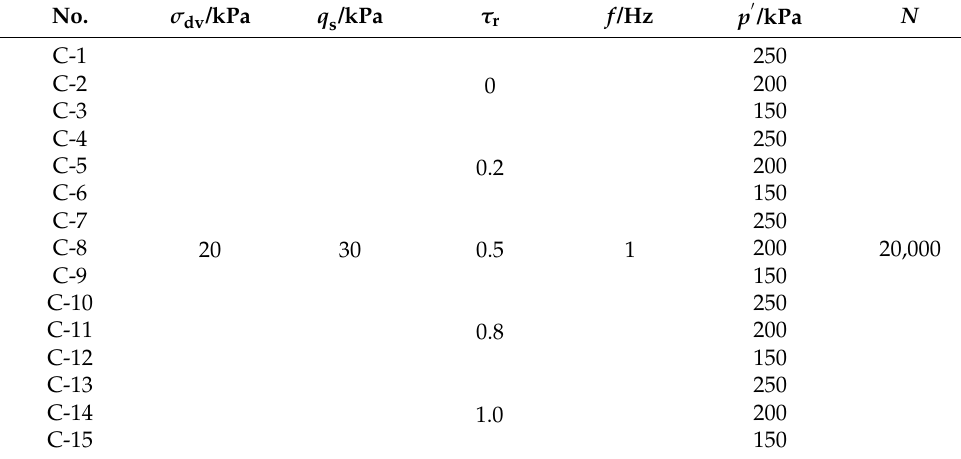
Table 3. Dynamic triaxial testing of soft